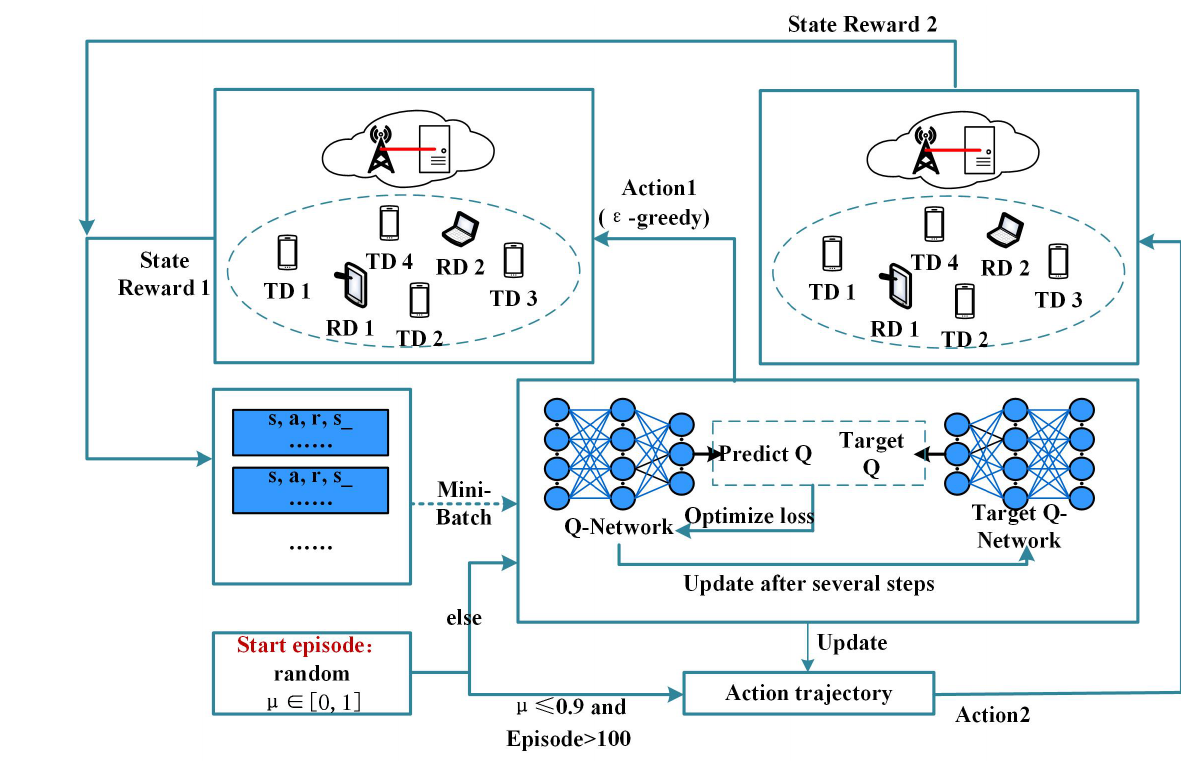
Figure 2. DQN-PTR based MEC